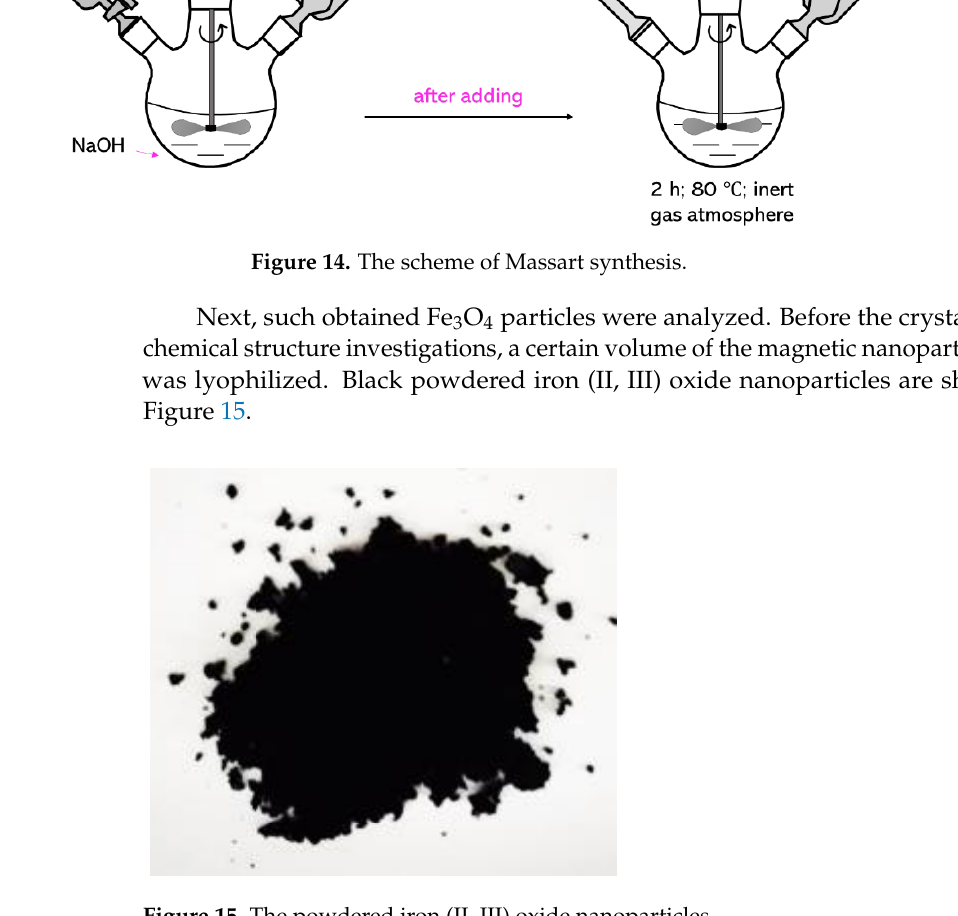
Figure 15. The powdered iron (II, III) oxide nanoparticles.